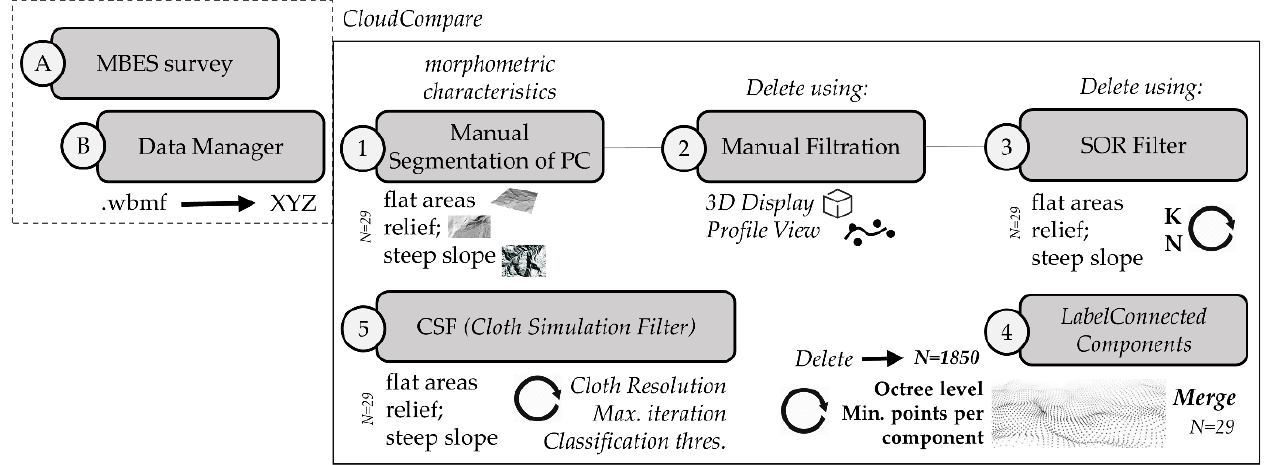
Figure 10. A proposed new and user-friendly framework for MBES point filtering in CloudCompare.